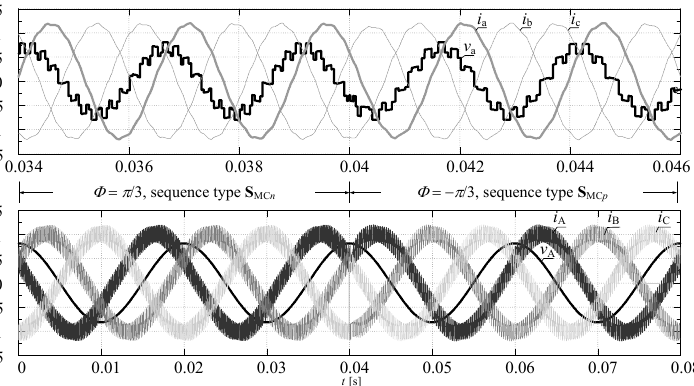
Figure 17. The zoom of the rapid change of switch sequence type for PWR modulation and load model-2, q = 0.866, and k f = 8.